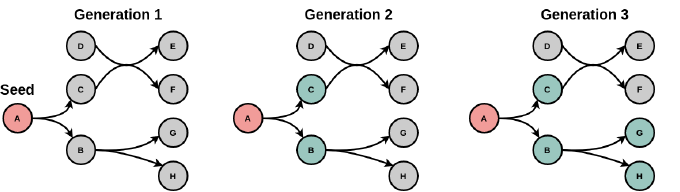
Figure 2. Metabolic network expansion. Beginning with an initial set of compounds, the seed (here panel 1), the expansion process detects all producible compounds in a network and adds them to the seed for the next generation until no additional producible compounds are